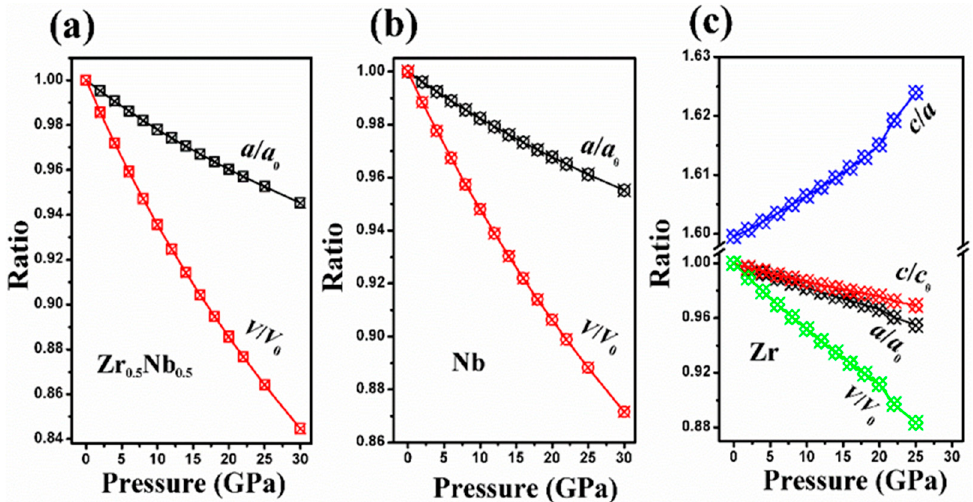
Figure 1. Normalized lattice parameters and unit-cell volumes vs. pressures for cubic Zr 0.5 Nb 0.5 alloys ( a ), Nb ( b ), and hcp -Zr metals ( c ), respectively.